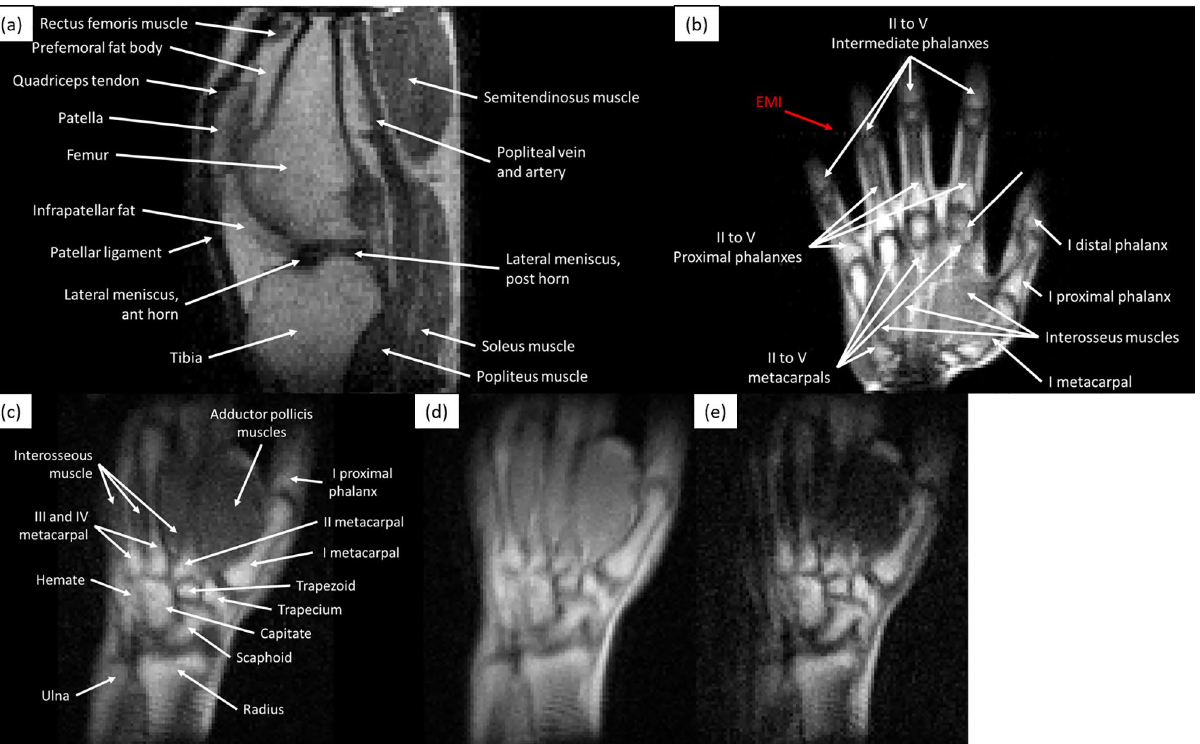
Figure 2. Single slices of 3D-RARE in vivo acquisitions of different volunteers in the MRI physics laboratory: ( a ) T 1 -weighted image of a knee, acquired in 19 min; ( b ) T 1 -weighted image of a hand (10 min), with a faint EMI line visible along the phase-encoded direction; ( c )–( e ) T 1 , ρ and T 2 -weighted images of a wrist (12 min).